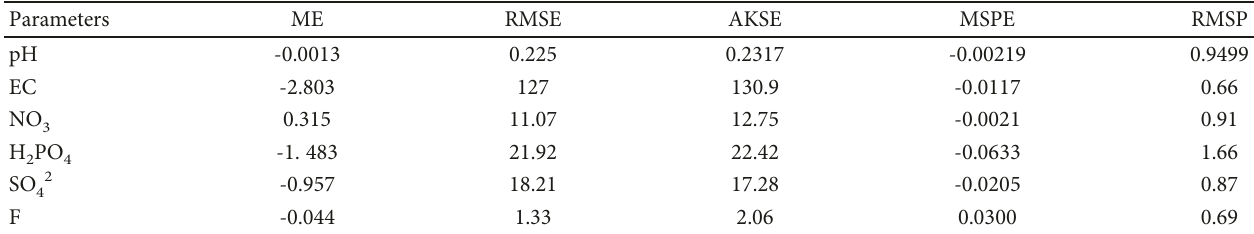
Table 1: Fitted parameters of variogram for groundwater quality prediction